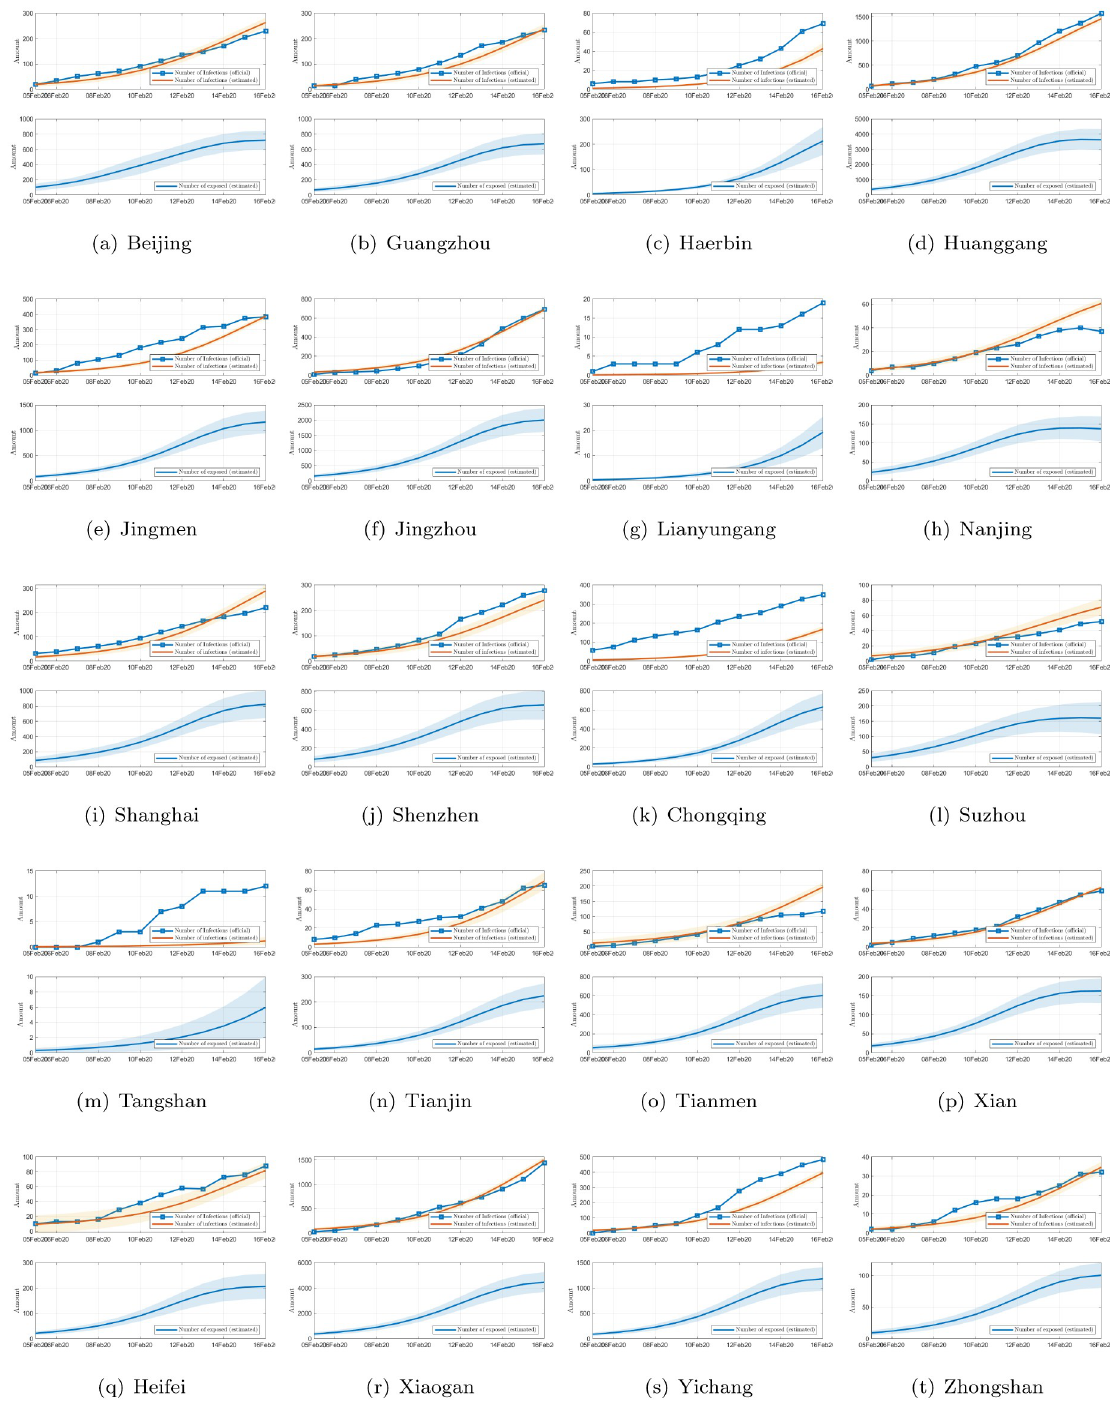
Fig 4. Official number of infected individuals and estimated number of infected individuals in 20 selected cities in China (upper), and estimated number of exposed individuals (lower), while the filled area shows the 95% confidence interval.